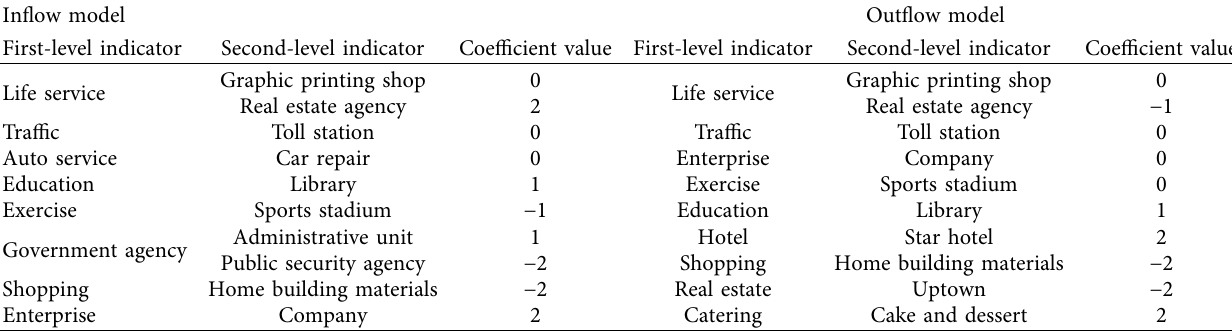
Table 11: Top 10 variables with the smallest absolute value of coefficient in